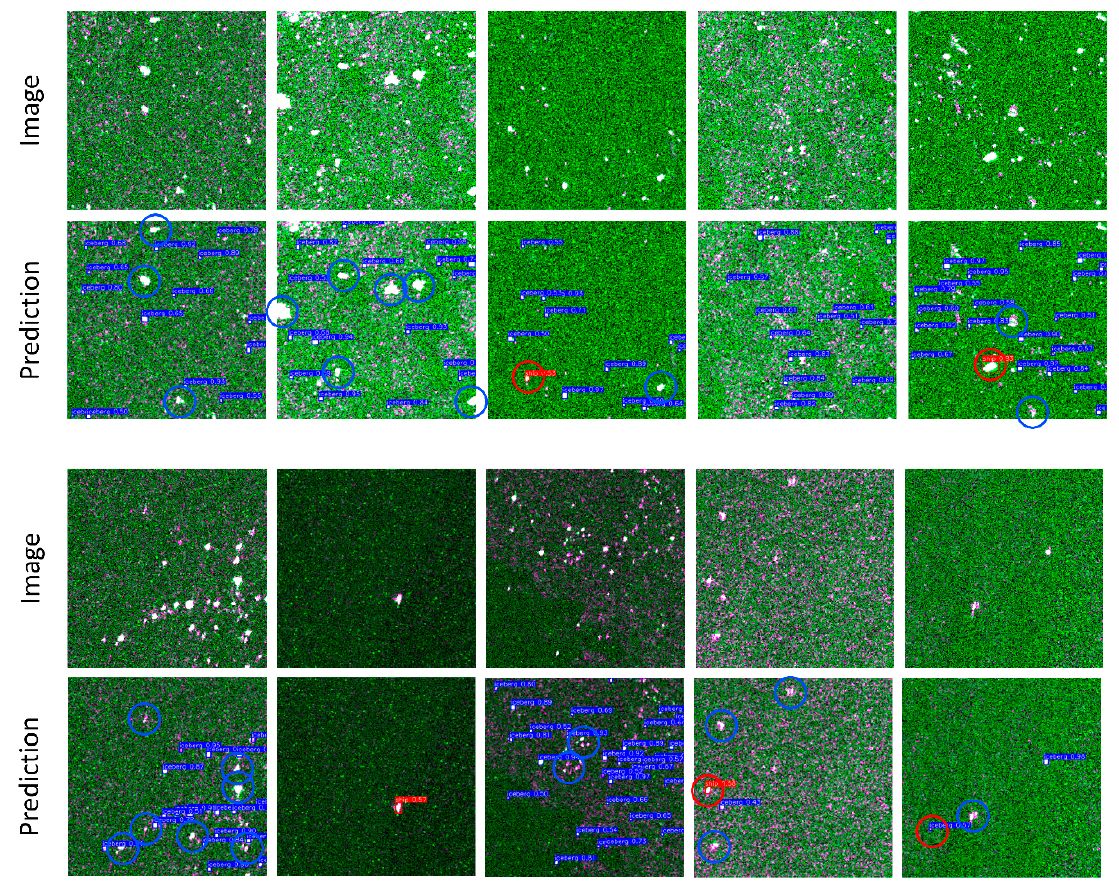
Figure 3. Input Sentinel-1 RGB composite images and output predictions, blue labels are predicted icebergs and red labels are predicted ships. Blue circles are false negatives and red circles are false positives.